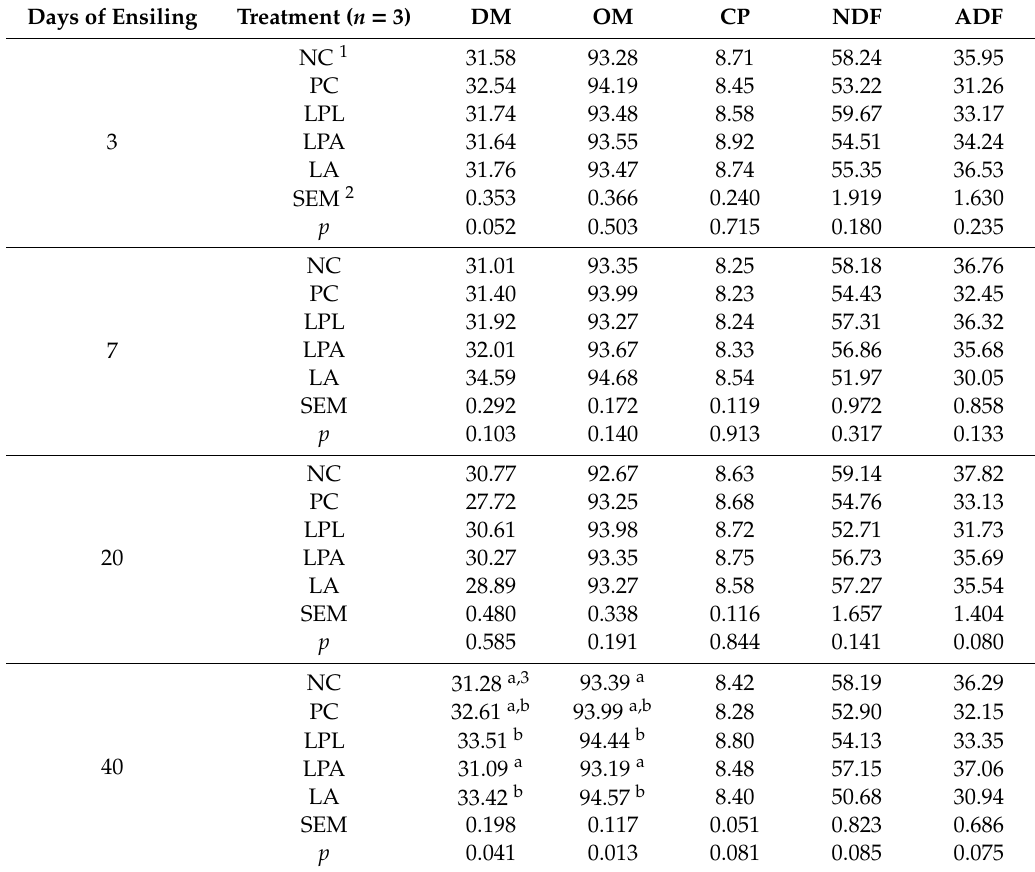
Table 1. E ff ect of di ff erent lactic acid bacteria on the chemical composition (%) of maize silage (dry matter basis unless otherwise